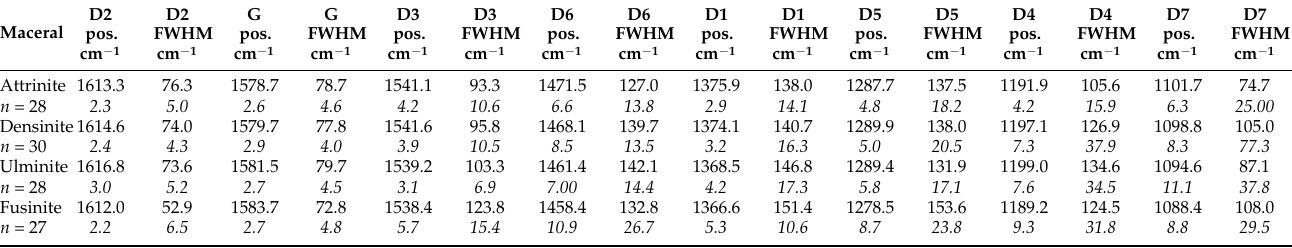
Table 4. Band positions and full width at half maximum (FWHM) in the spectra of the studied macerals. D2 D2 Maceral pos. FWHM cm − 1 cm − 1